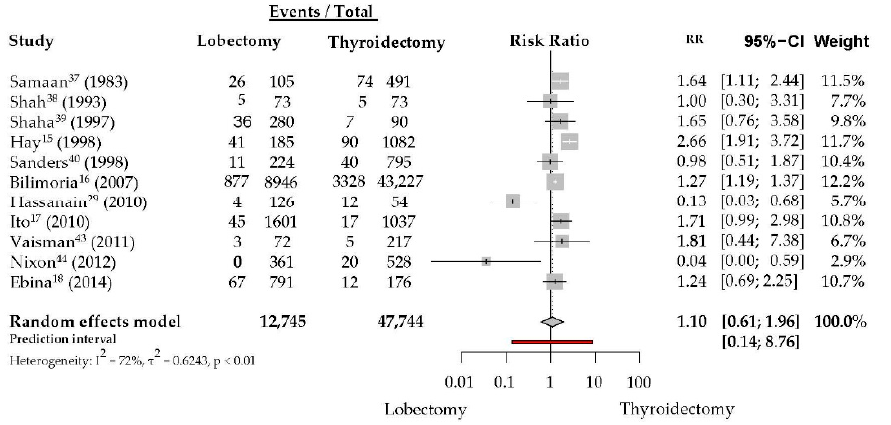
Figure 2. Recurrence rates of differentiated thyroid carcinoma after total thyroidectomy versus lobectomy.